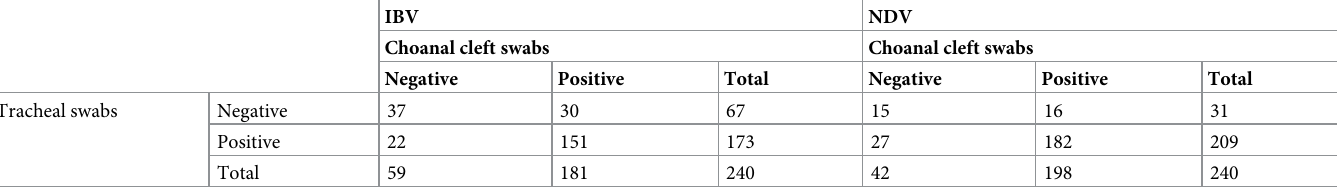
Table 3. Number of birds positive and negative for IBV and NDV GC in choanal cleft and tracheal swabs. IBV NDV